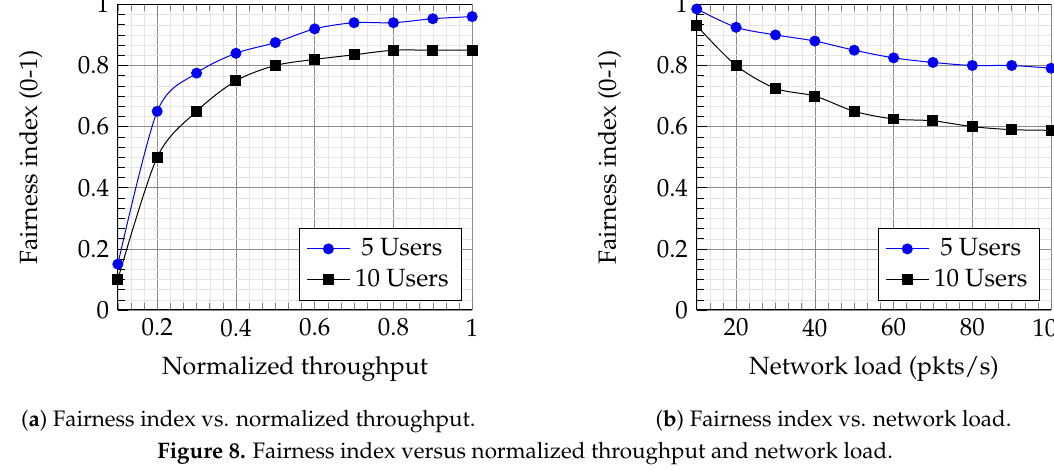
Figure 8. Fairness index versus normalized throughput and network